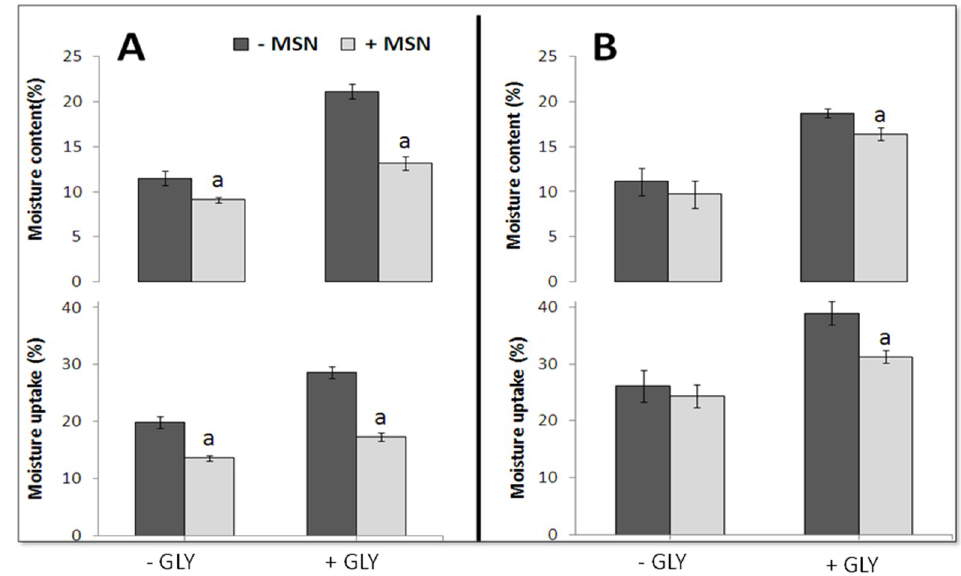
Figure 3. Effect of MSN on moisture-content and uptake of PEC ( A ) and CH ( B ) films, prepared with or without GLY. “a” values significantly different at p < 0.05, from those obtained without MSN.